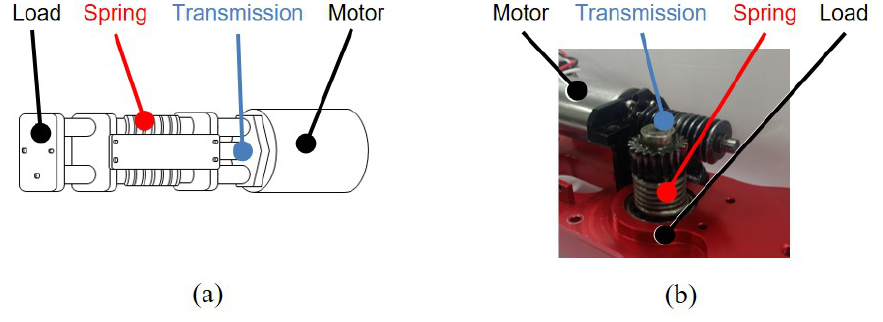
Figure 5. Example models of FSEA. ( a ) Series Elastic Actuator (SEA) and ( b ) compact Rotary Series Elastic Actuator